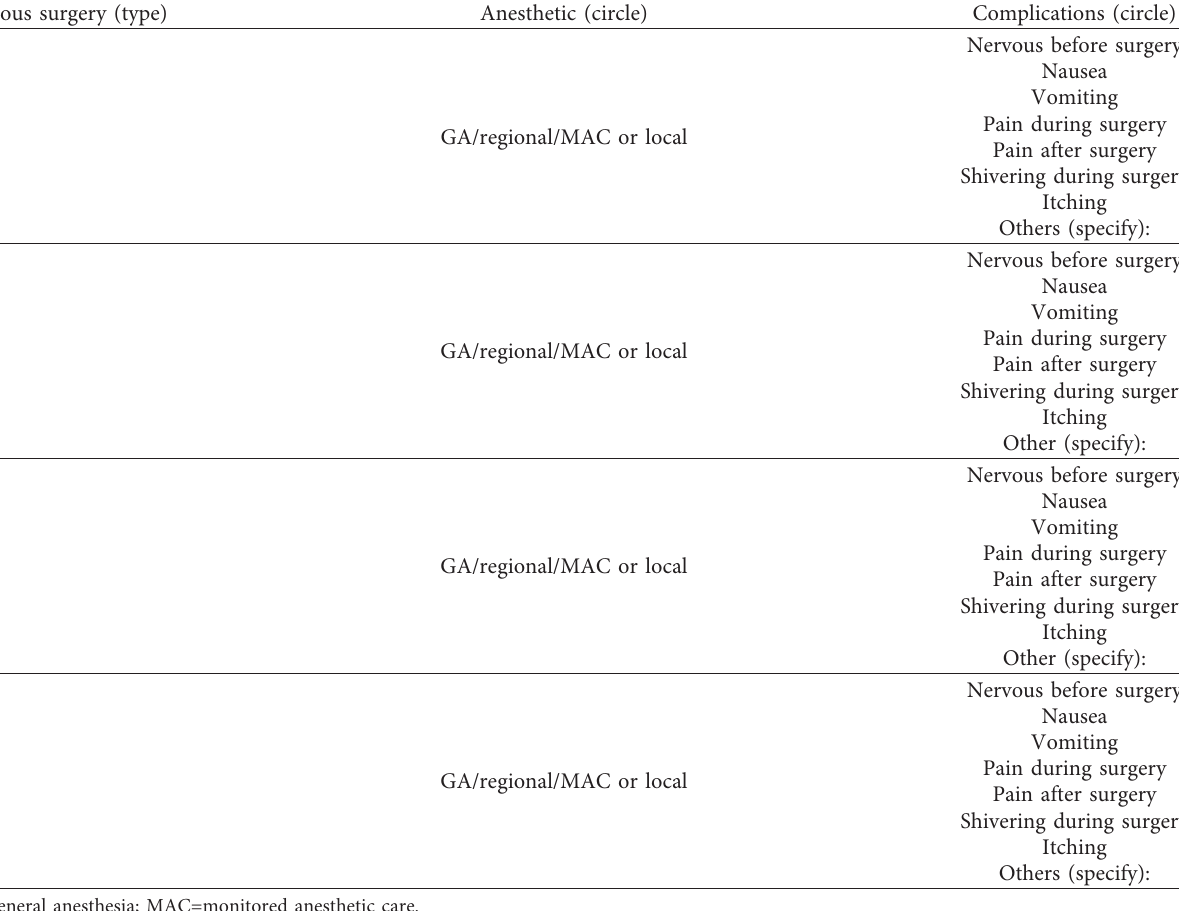
Table 4: Surgical history.